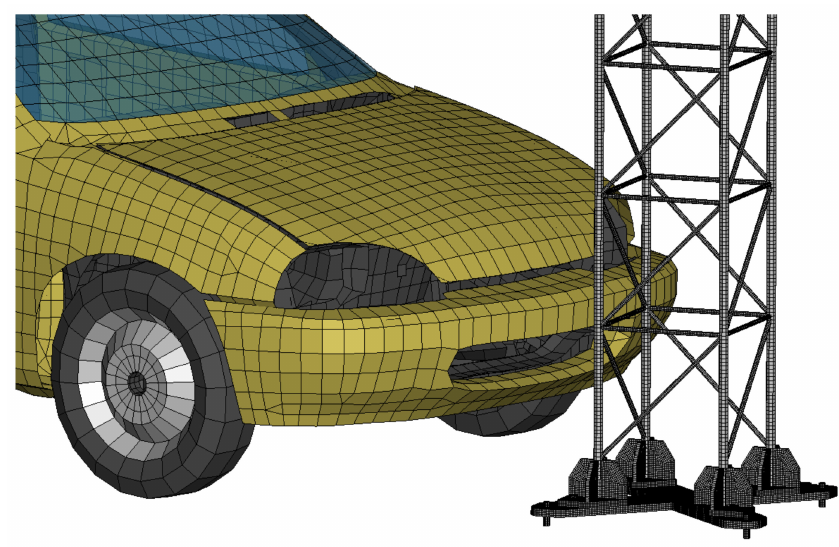
Figure 7. Numerical model of the supporting mast of the road sign with GeoMetro vehicle. The vehicle velocity was set with the application of the INITIAL_VELOCITY_ GENERATION card giving the nodes incorporated in the wheel structure the rotation velocity about the rotation axis. At the moment of an impact, the vehicle traveled with a linear velocity corresponding to experimental conditions, i.e., 35 km/h or 100 km/h. The supporting mast was fixed in place by removing degrees of freedom from nodes composing the base of anchors connecting the base plate with the foundation. The influence of gravity was taken into account in the